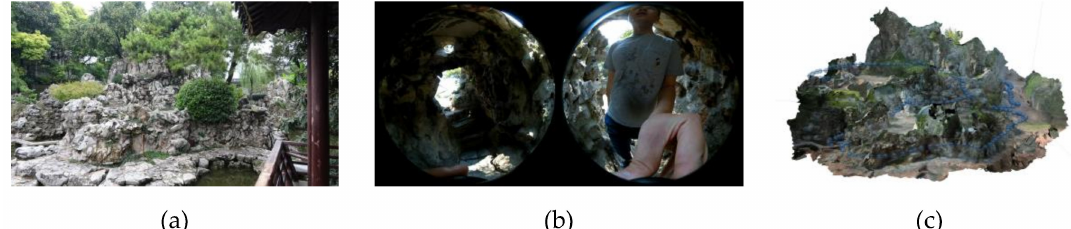
Figure 1. 3D reconstruction of the rockery in a Chinese classical garden through combined use of a consumer-level spherical camera and a typical structure from motion (SfM) workflow. (a) A view of the north rockery in Zhan Garden, Nanjing; (b) an example of raw video frames; and (c) the 3D model and recovered frame